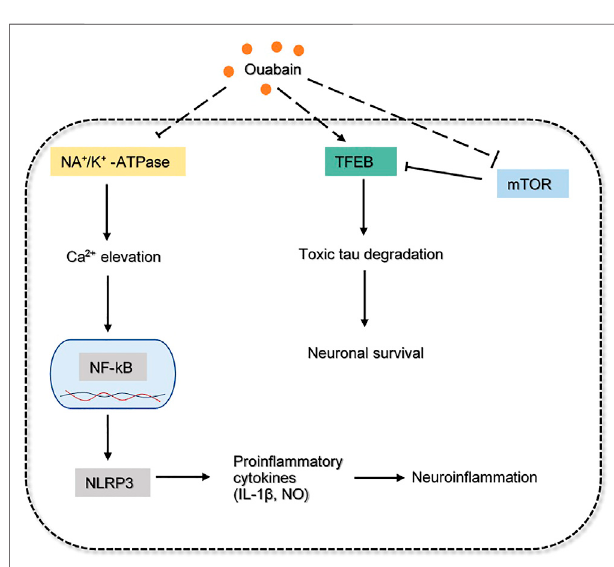
FIGURE6| TheinferredmechanismofouabaininADpathology.Thedrug acts through the inhibition of Na/K + -ATPase, mTOR and activation of TFEB. The deactivation of Na/K + -ATPase prevents excessive Ca 2+ in fl ux that leads toproductionofproin fl ammatorycytokines. The druginhibitsmTORwhile augmenting TFEB can indicate a better ef fi cacy in toxic tau degradation leading toneuronalsurvival.Thesoliddashlinesshowtheinteractionsofproteinkinases. The long-dashed lines show the pharmacological action of the